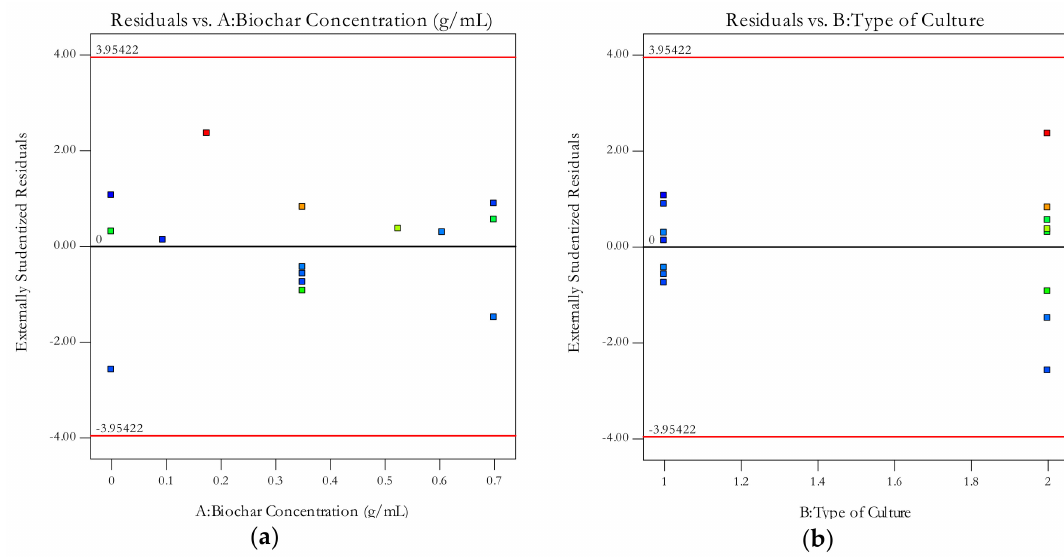
Figure A4. Plots of the residuals versus ( a ) biochar concentration and ( b ) type of